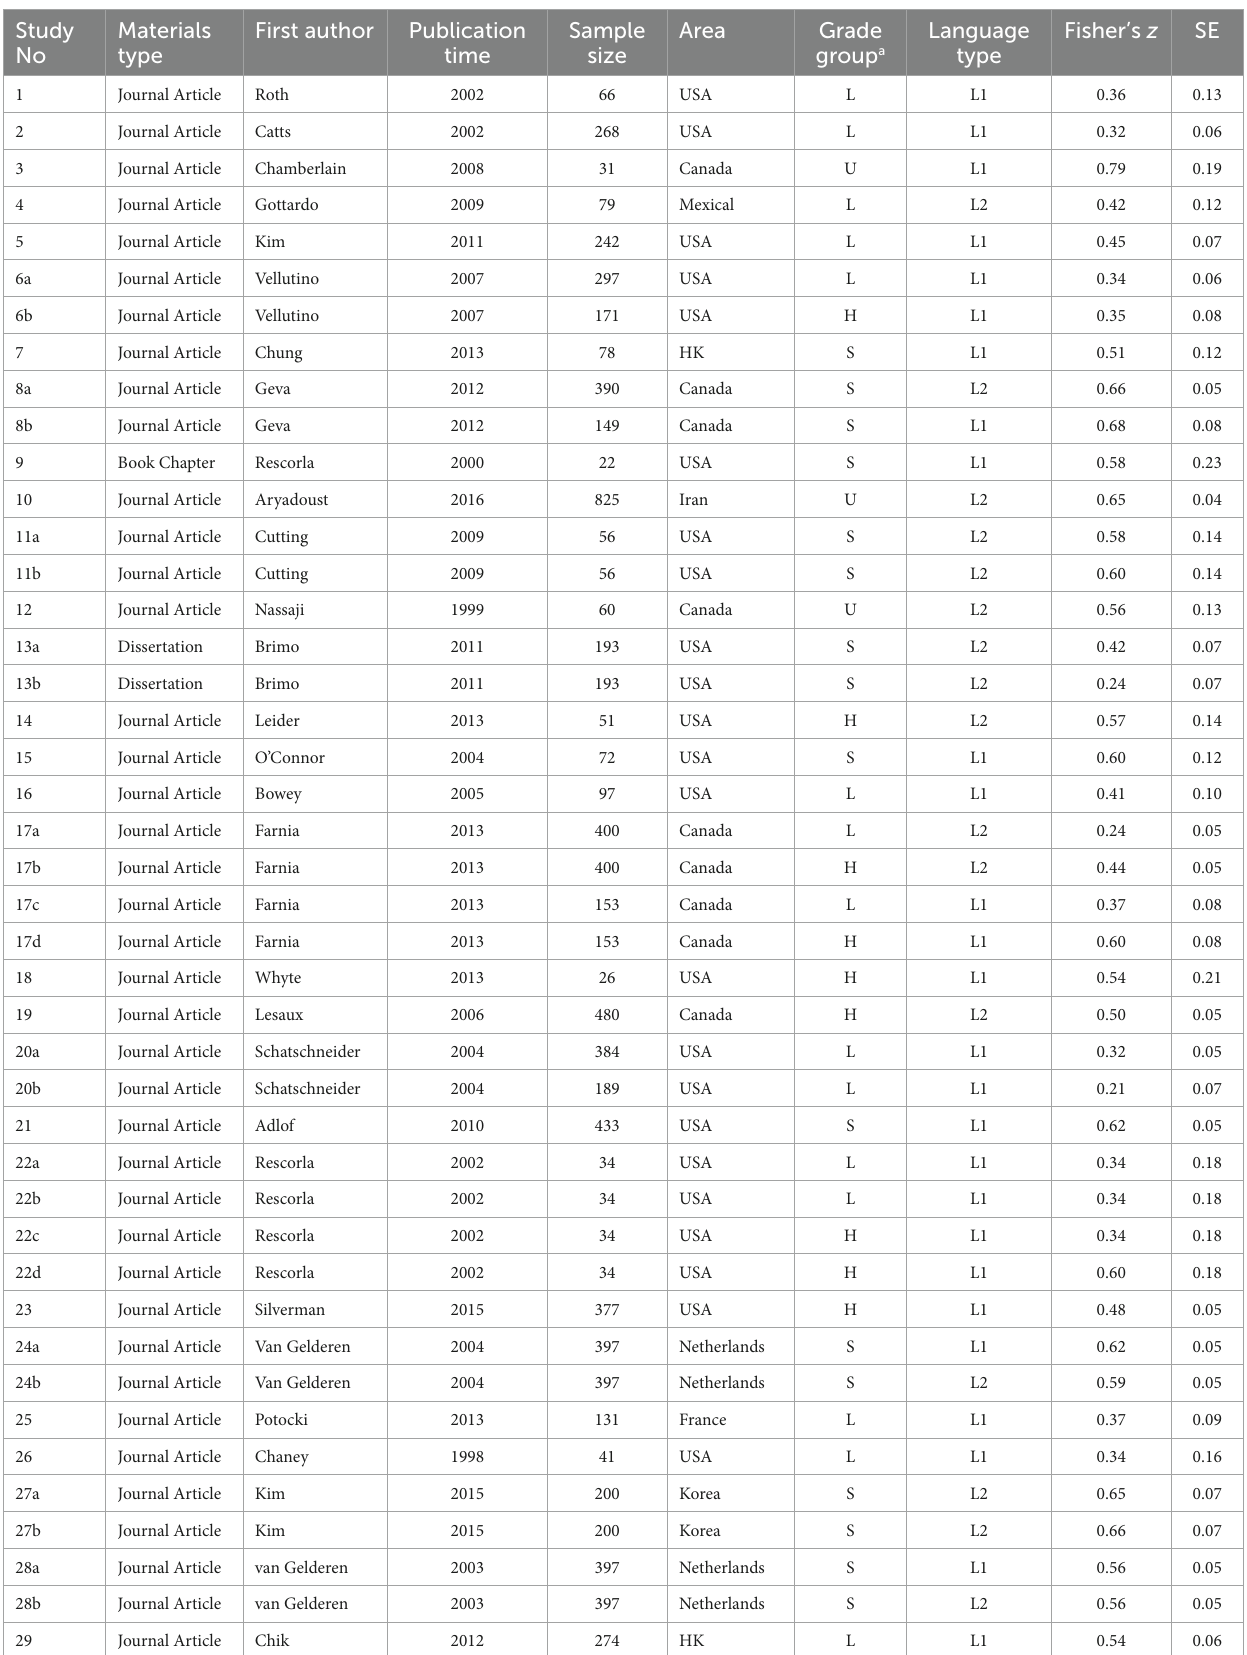
TABLE 1 Moderators and outcomes for the matched set of self-report studies in